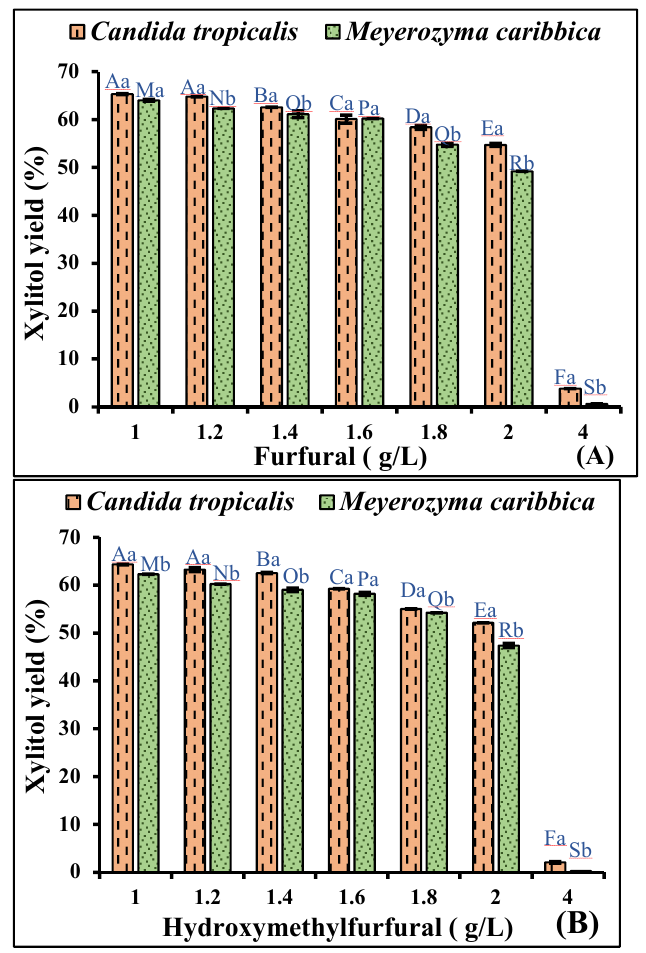
Figure 2. Effect of inhibitory compounds ( A ) furfural, ( B ) hydroxymethylfurfural (HMF) on xylitol fermentation efficiency of C. tropicalis and M. caribbica in rice straw hydrolysate. Significant differences were calculated by two-way ANOVA using Bonferroni post-tests and are indicated by small and capital letters. In different concentrations of furfural and HMF, bars with different uppercase letters are significantly different, while bars with lowercase letters represent a significant difference in xylitol production by the two yeasts. Different letters denote a significant difference between the two, and the same letters on the bar denote no significant difference between the two at p < 0.0001.